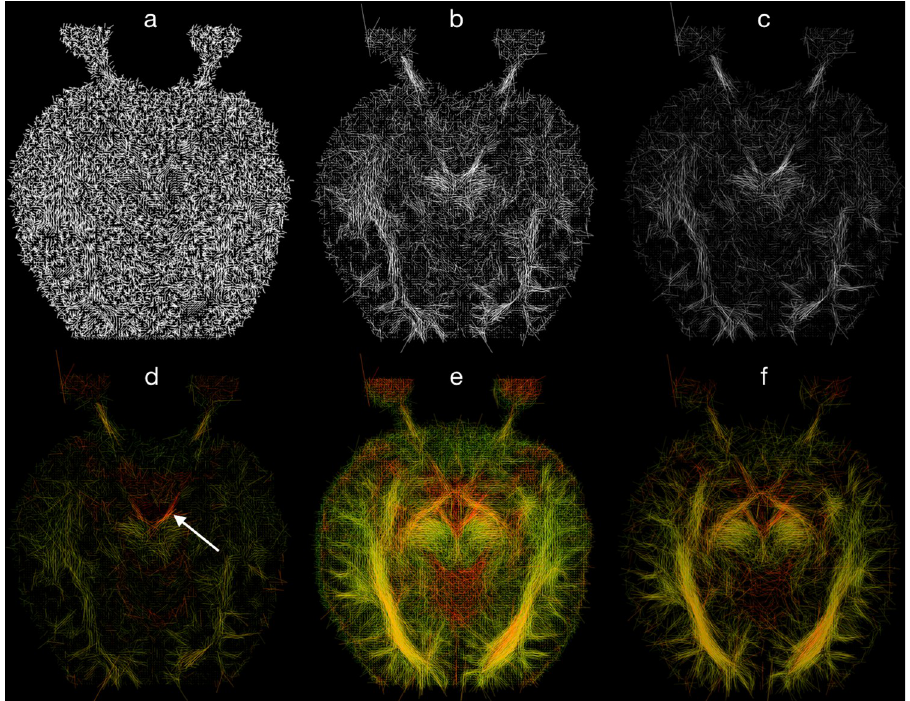
Fig 2. The visual effect of the algorithm in six steps for a healthy subject, a–principal diffusion directions shown as line segments, b–length coding, c–opacity coding, d–color coding, e–seven layers projection, f–seven layers projection and data thresholding. In a-d a single layer was used. White arrow: oculomotor nerve. Orientation convention: Radiological.